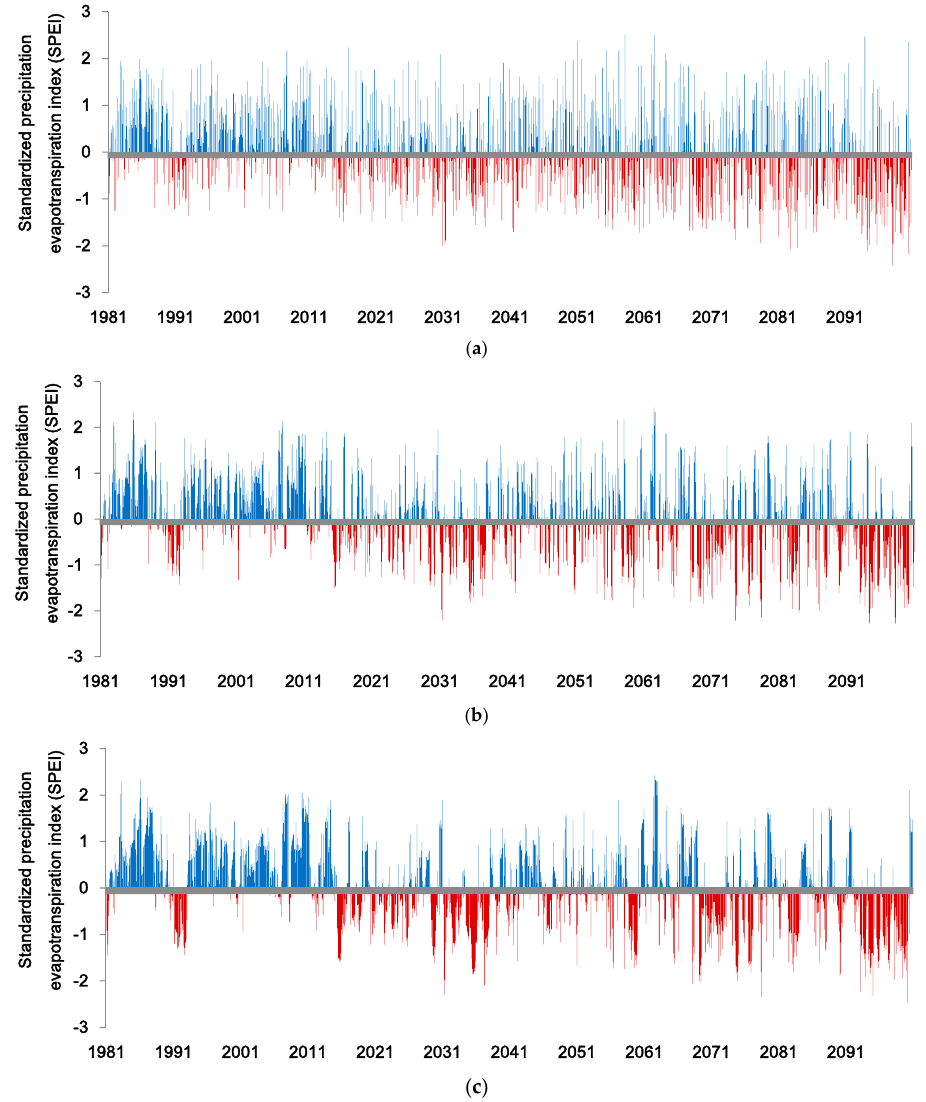
Figure 5. SPEI on different timescales (one, three, and six-month) from 1981 to 2100: ( a ) one-month SPEI; ( b ) three-month SPEI; ( c ) six-month SPEI. Table 3. Conditional probability of multiple timescale SPI (A) and SPEI (B).